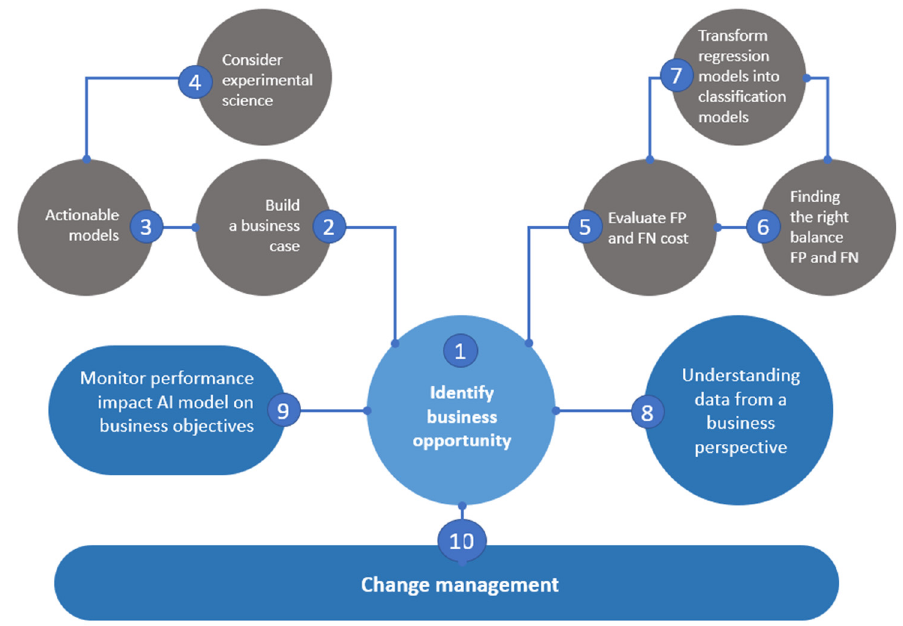
Figure 9. Detailed Methodology Business Design IA Models. Source: own